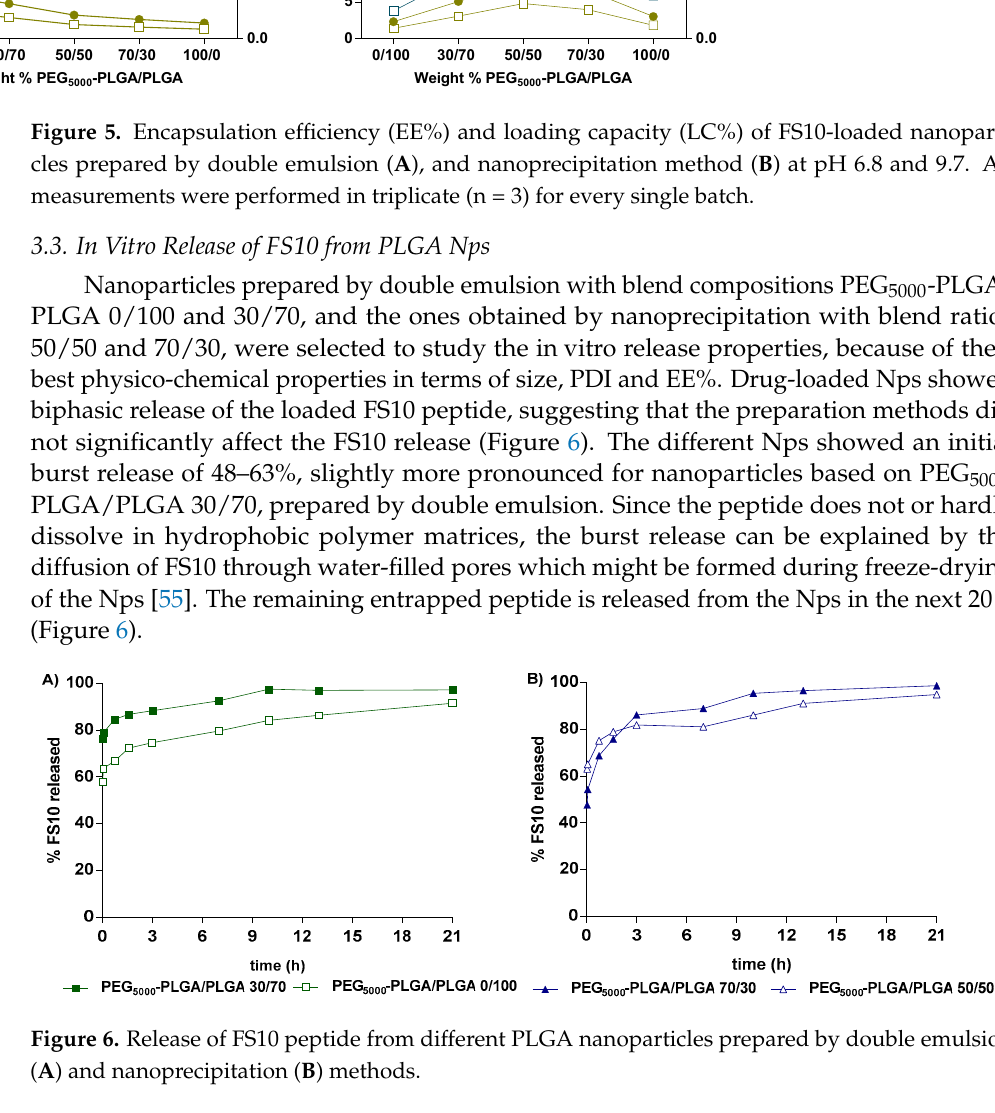
Figure 7. TEM images of empty Nps (blank) and FS10-loaded Nps. Empty Nps ( a , c ); FS10-loaded Nps ( b , d ). ( c , d ) are high magnification. Different formulation strategies have been reported in the literature to overcome the critical issues related to the challenging delivery of hydrophilic compounds [23]. Budhian et al. improved the EE% of haloperidol up to 30% using acid terminated instead of ester capped PLGA [56]. Moreover, Imatinib mesylate was formulated in PLGA microspheres with high EE and LC by optimizing the pH of the internal (W1) and external (W2) water phases [57]. In our case the combination of different strategies allowed to increase the encapsulation efficiency of FS10, highlighting that the most influential parameters are